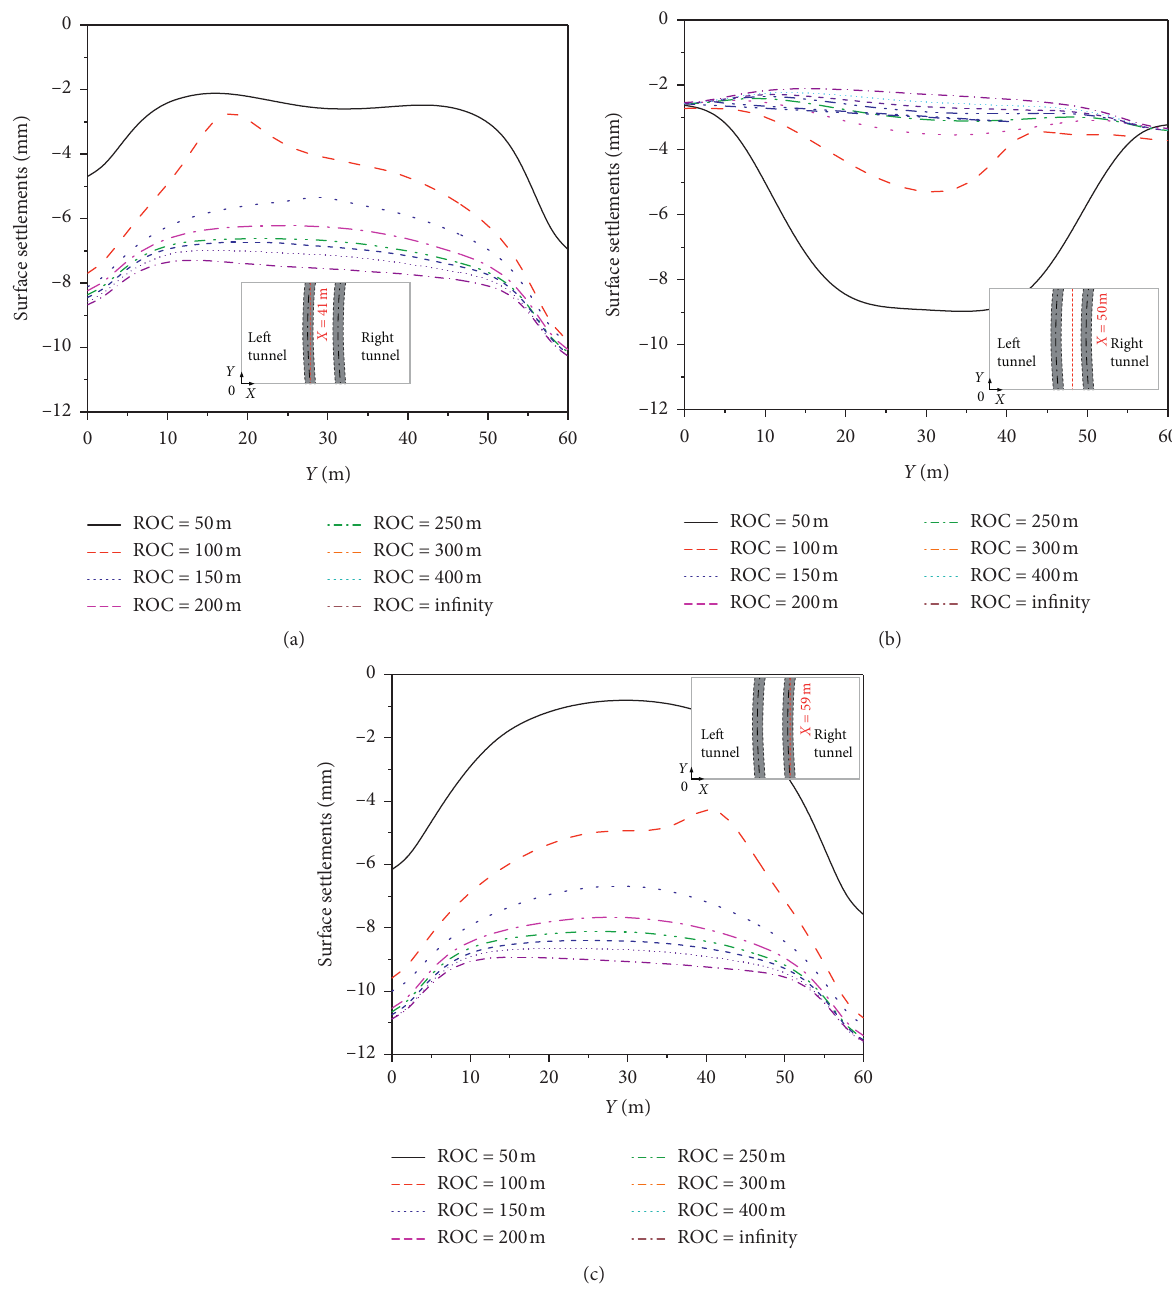
Figure 10: Distributions of ground surface settlements at the final step induced by curved tunnelling at various radii of curvature along: (a) X � 41m, (b) X � 50m, and (c) X �